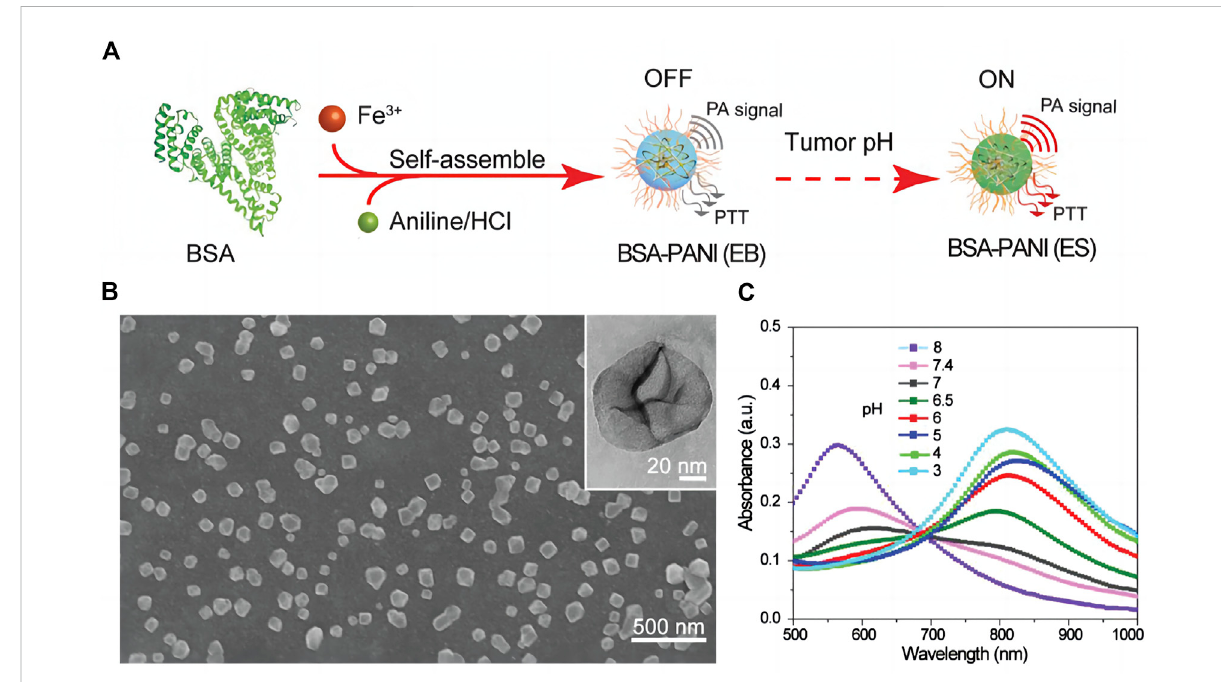
FIGURE 4 Assembly and characterization of tumor pH-responsive bovine serum albumin (BSA)-polyaniline (PANI)assemblies (A) Schematic illustration of the preparation process. (B) SEM and TEM (inset) images of the BSA – PANI assembly. (C) Absorption spectra of BSA – PANI assemblies dispersed in buffer solutions with different pH values [reproduced from (Tian et al., 2019) with permission from John Wiley and